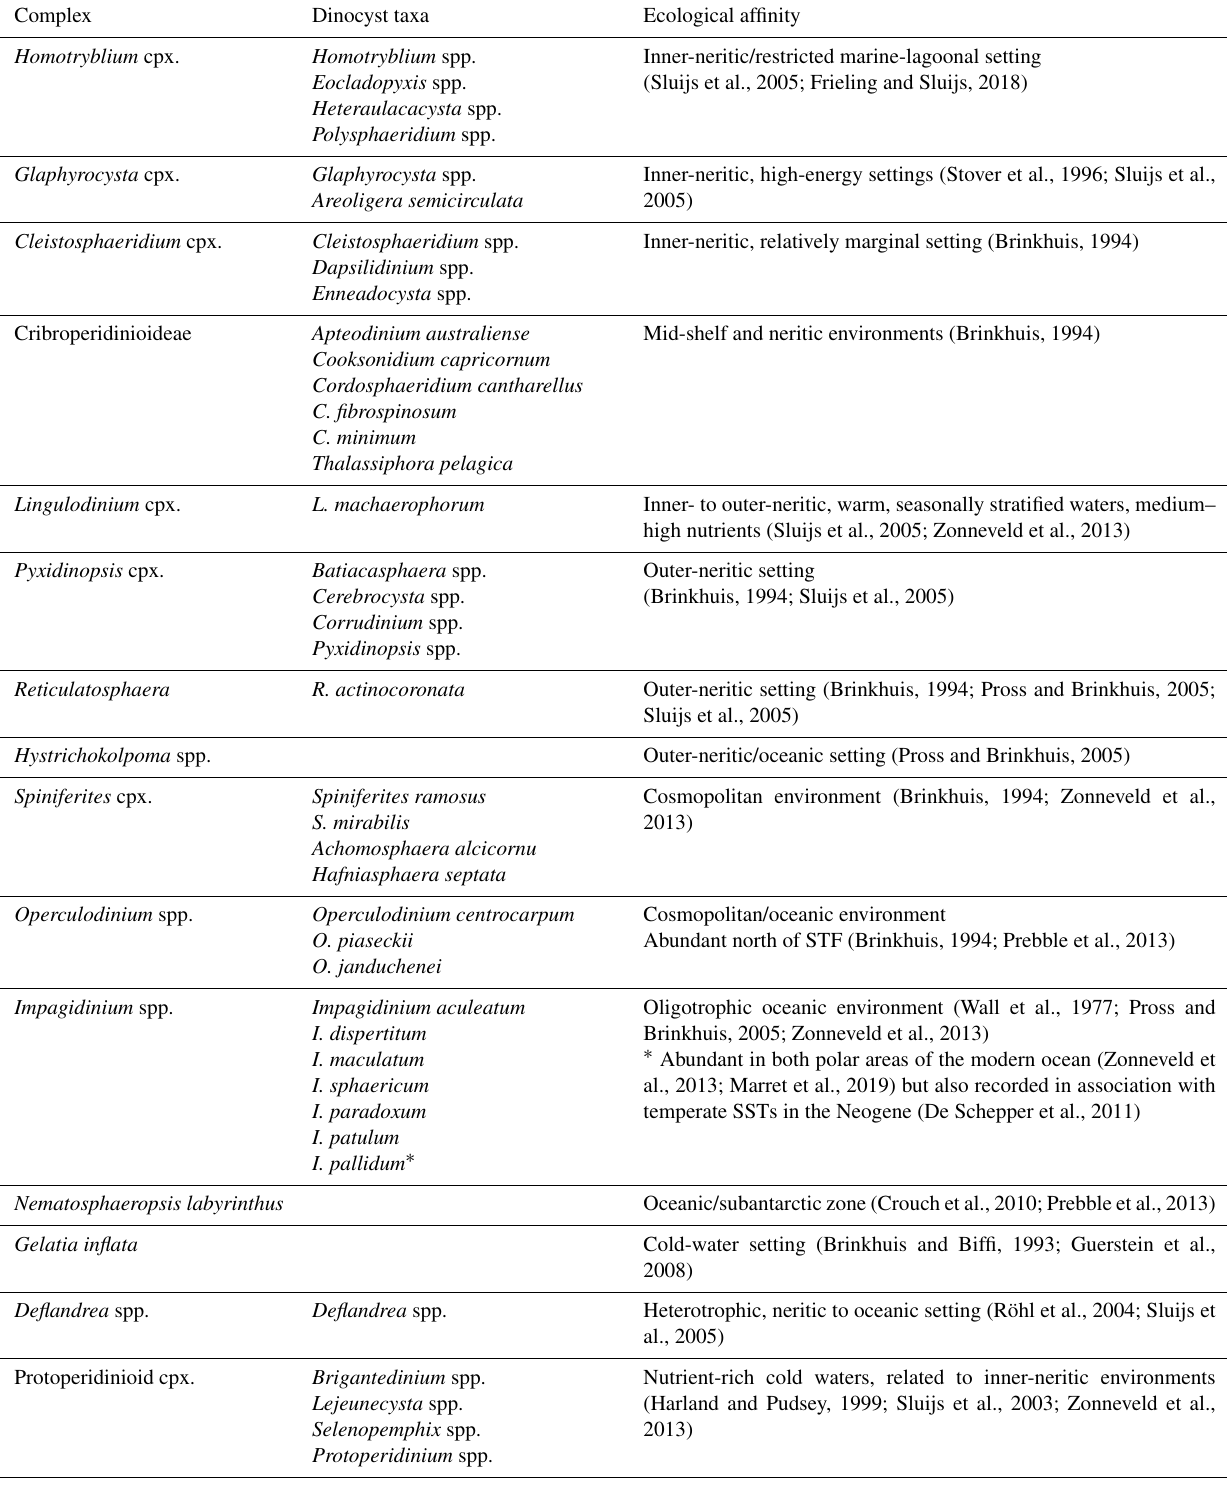
Table 1. Dinocyst assemblage groups and their ecological and frontal system affinity. Complex Homotryblium